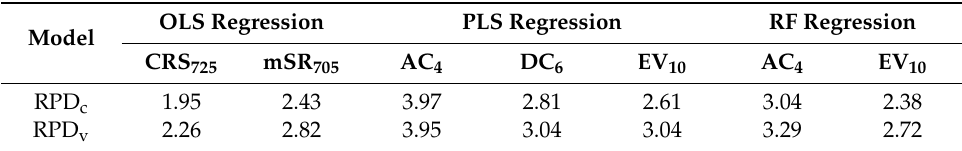
Table 9. The ratio of prediction to deviation (RPD) values in the calibration models and validation models of leaf nitrogen